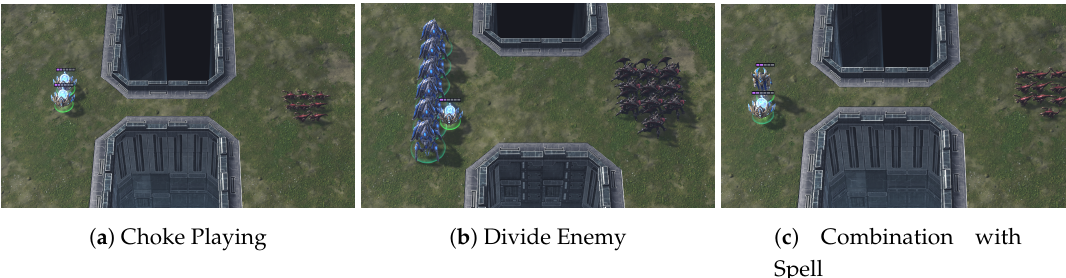
Figure 4. Initial minigame settings before